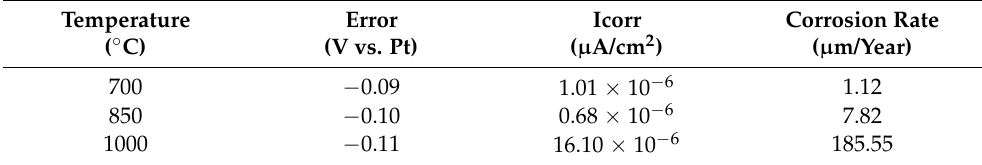
Table 2. The corrosion potential, current density, and corrosion rate obtained for Bi 3.75 La 0.25 Ti 3 O 12 at 700 ◦ C, 850 ◦ C, and 1000 ◦ C.